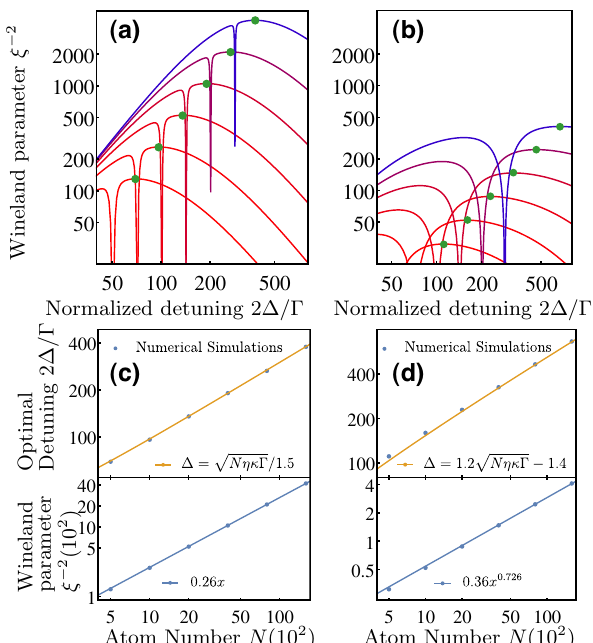
FIG. 5. (a),(b) The optimal Wineland parameter with respect to the optimized photon number at given N and detuning, with- out (a) and with (b) Bloch sphere curvature effect, where the atom numbers are N = { 1, 2, 4, 8, 16 } × 500 (in order from bot- tom to top). The single-atom cooperativity is η = 1.8. The green dots indicate the maximum Wineland parameter for a given atom number. (c),(d) The optimum detuning and maximum Wineland parameter as a function of the atom number, corresponding to the parameters of the green dots in subfigures (a),(b); the data points correspond to numerical simulations and the solid lines represent fits that hold for large atom number N (cid:15)